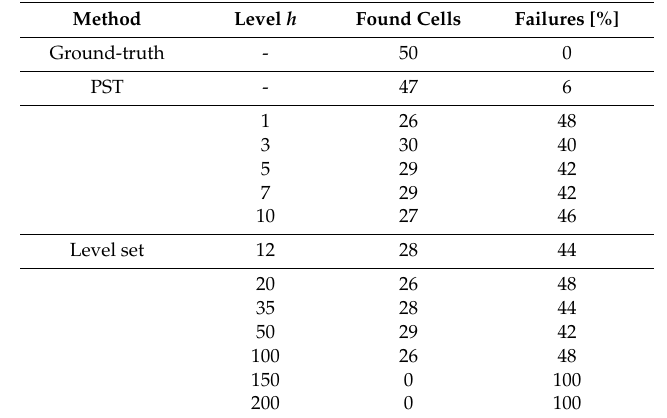
Table 4. Results obtained with the proposed method and the level set algorithm for di ff erent values of level h .